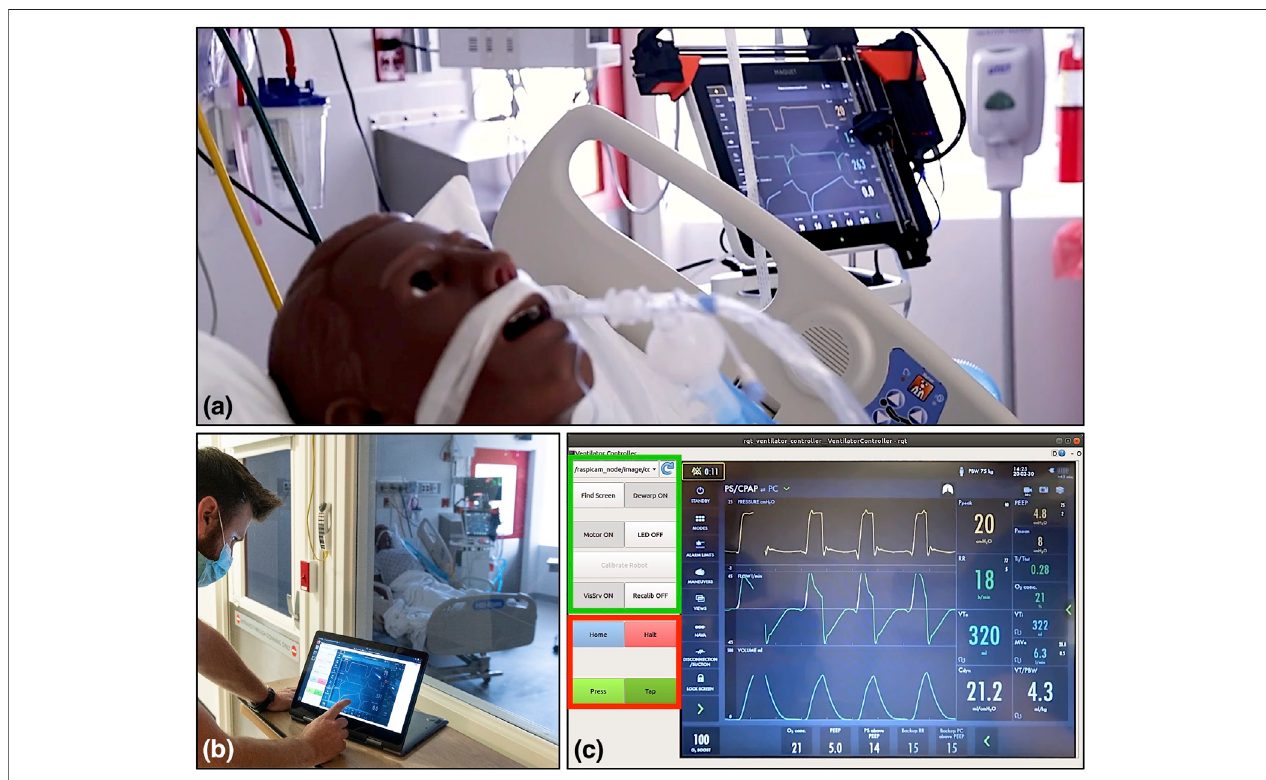
FIGURE 5 | Evaluation of the ventilator controller system on a human body phantom in the Johns Hopkins Hospital ’ s biocontainment unit (BCU). (A) Robot mounted on the screen of a Maquet Servo-U ventilator, (B) respiratory therapist using the remote controller software on a tablet computer outside the BCU, (C) remote controller user interface layout, with the setup group of controls indicated in green and the control group in red.